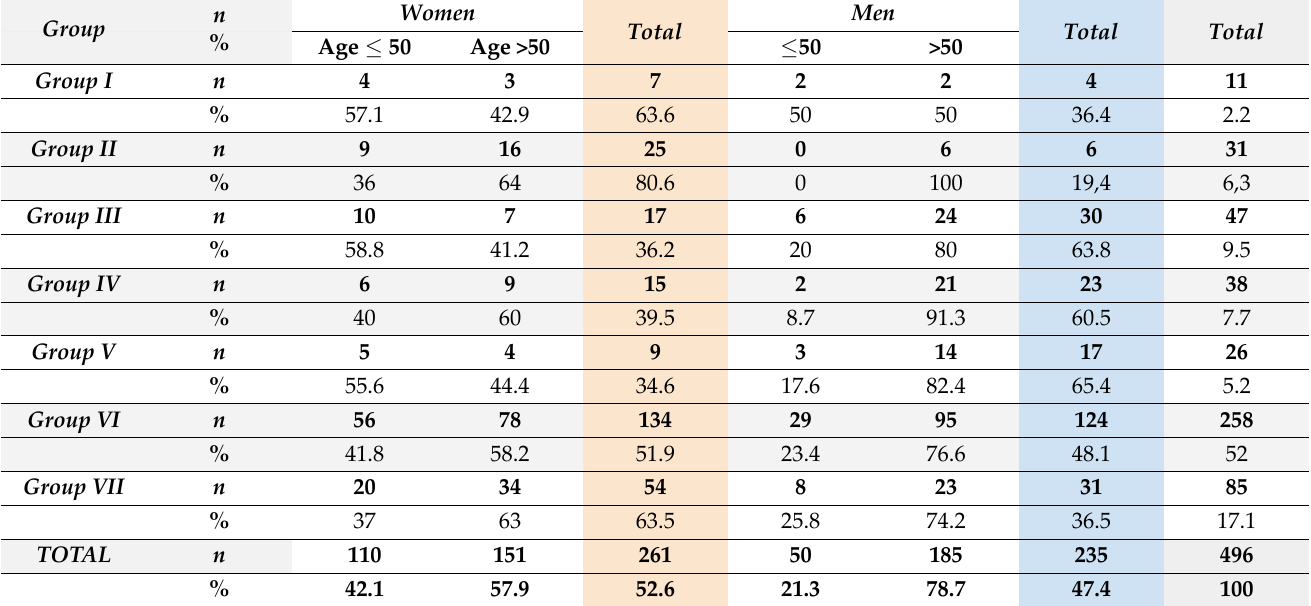
Table 3. Details of participants by medical specialty group, age, and gender. Women Men